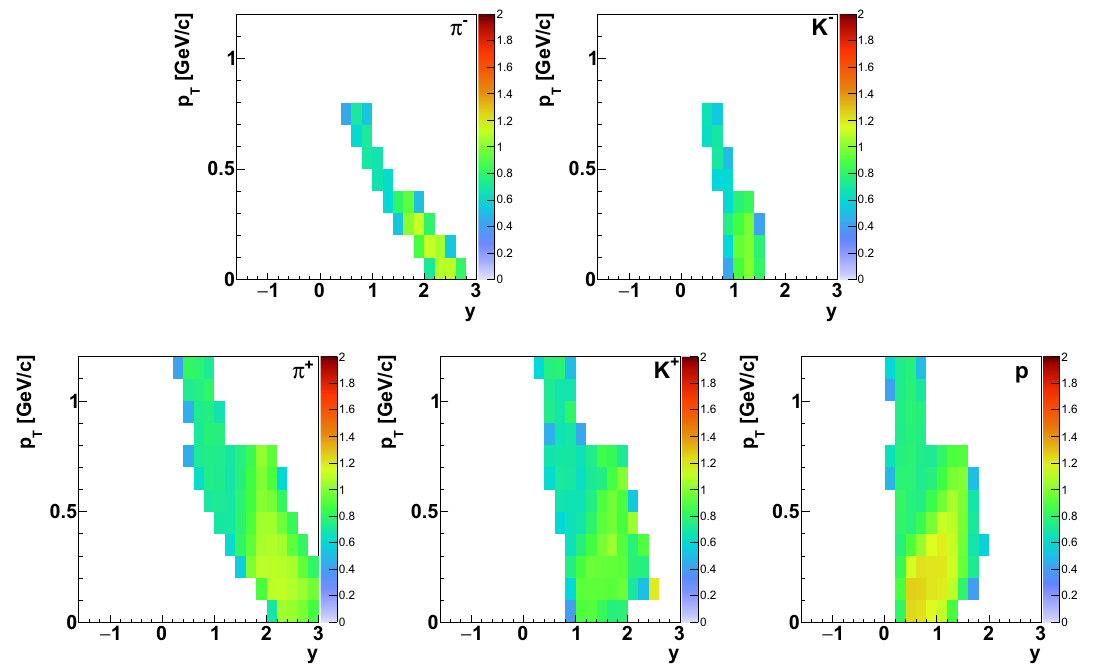
Fig. 12 Correction factors C − 1 for the d E / d x identification method for positively and negatively charged pions, kaons and protons in p + p i interactions at 20 GeV / c . The correction factor for antiprotons produced in inelastic p + p interactions is not presented due to insufficient statistics